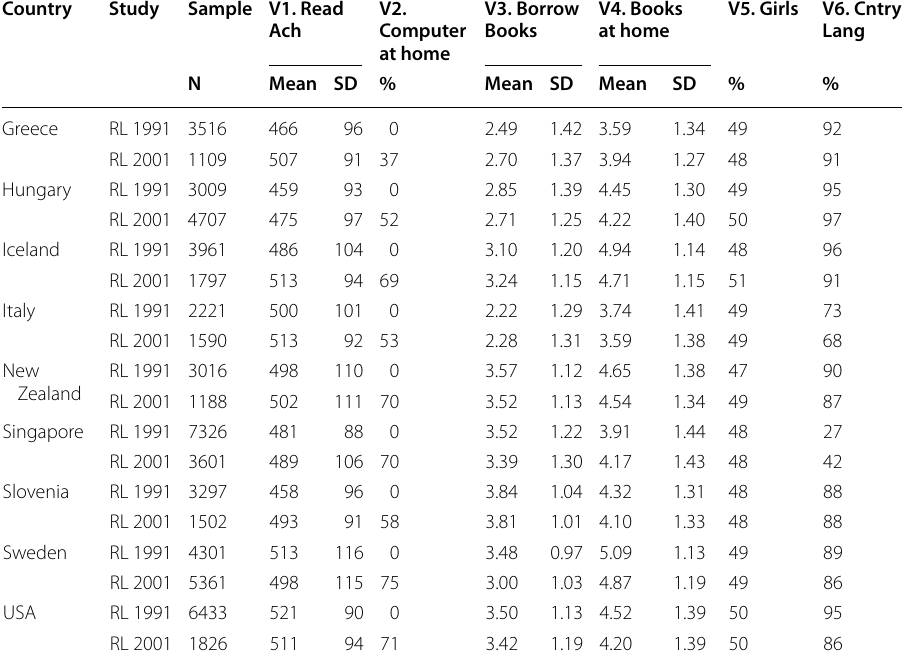
Table 1 Descriptive information at the country level, sample sizes and summary informa- tion for the selected variables for the period